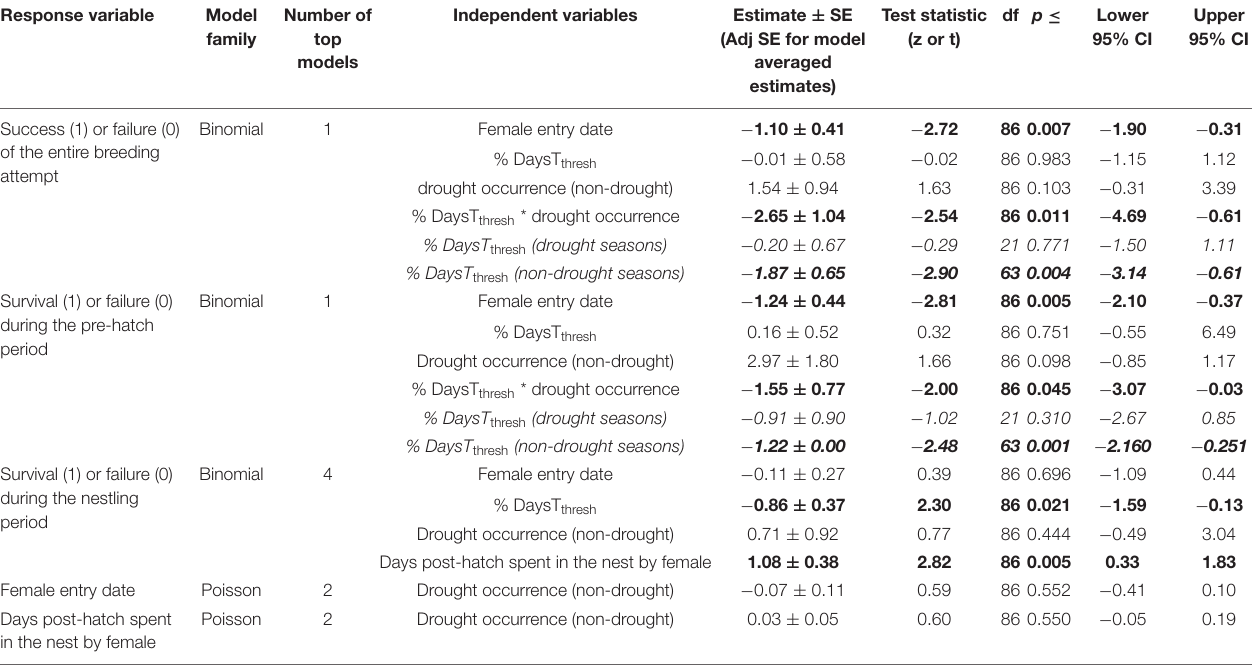
TABLE 2 | Bayesian generalized linear mixed model (BGLMer) of the outcomes of different stages [entire breeding attempt ( n = 88), nest survival from female entry until hatch/fail (“pre-hatch period”; n = 88), and nest survival from hatch until fledge/fail (“nestling period”; n = 88)] of individual breeding attempts in the southern yellow-billed hornbills ( Tockus leucomelas ) as functions of female entry date, percentage DaysT thresh {days during the attempt on which T max [mean maximum daily air temperature